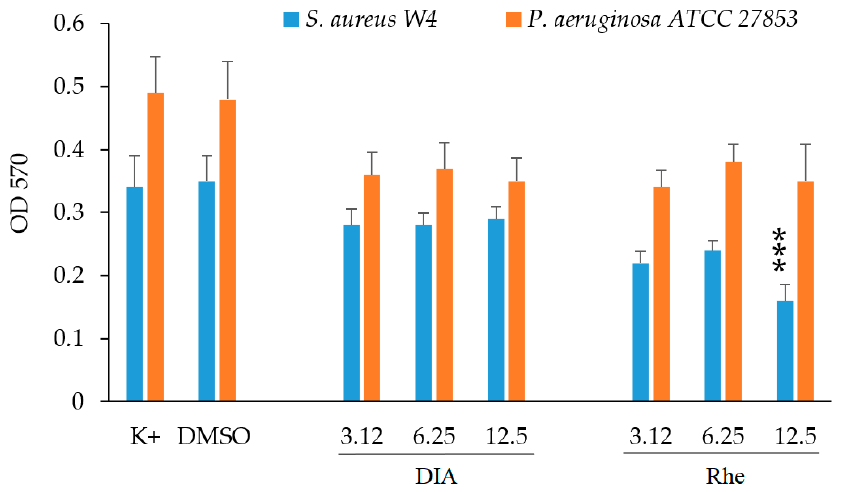
Figure 6. Anti-biofilm activity of DIA and Rhe against S. aureus W4 and P. aeruginosa ATCC 27853. Overnight bacterial cultures were diluted 1:100 and incubated with different concentrations of the two compounds. After 18 h of incubation at 37 °C, biofilm formation was quantified by CV staining. The figure depicts the mean values ± SEM of at least three independent experiments performed in duplicate. Concentrations are in μ g/mL. Control (K+) represents bacteria incubated in medium only. DMSO represents bacteria incubated in medium with the addition of 0.8% DMSO; *** p < 0.001 (one-way analysis of variance (ANOVA) followed by the Tukey–Kramer post hoc test).